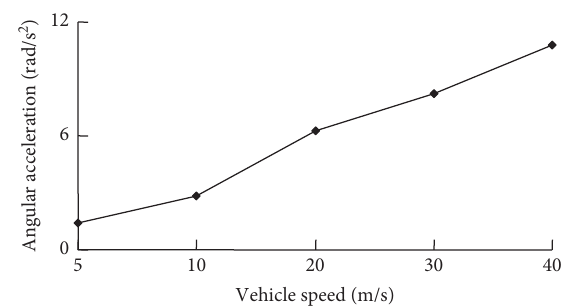
Figure 20: The variation curve of peak values of rolling vibration accelerations of the vehicle